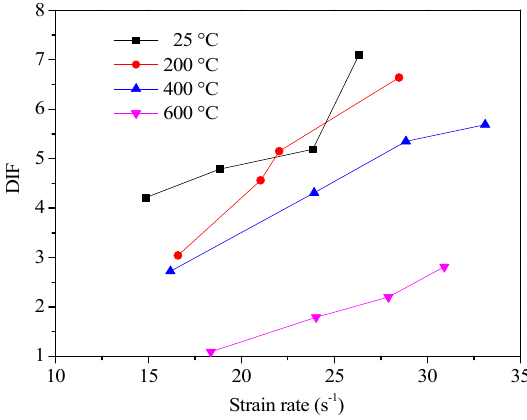
Figure 10. The dynamic increase factor vs. the strain rate.